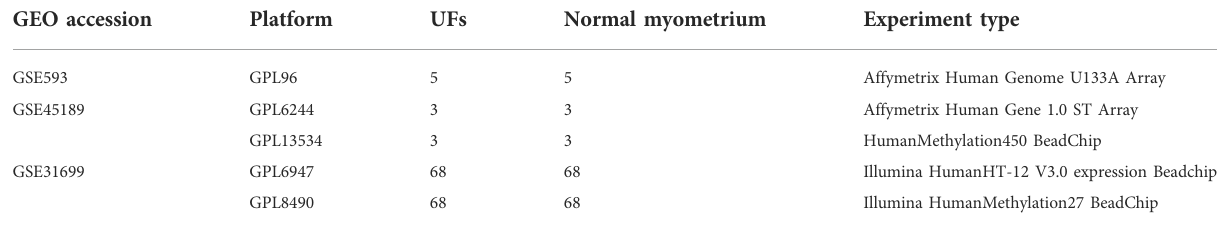
TABLE 1 Gene Expression Omnibus (GEO) data